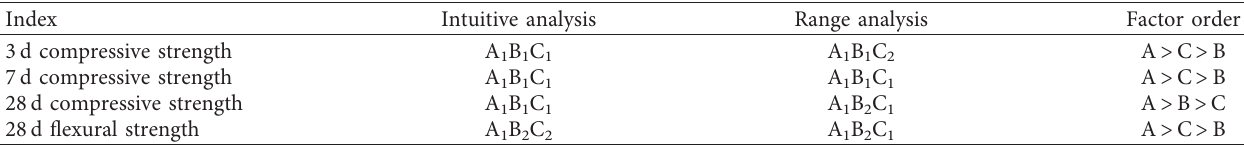
Table 8: Comparison of the optimal mix